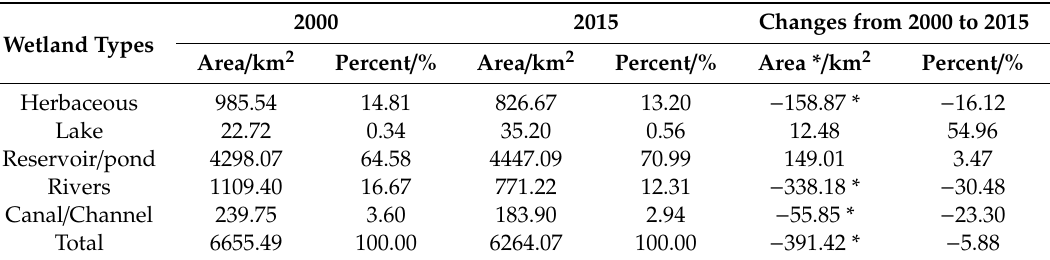
Table 1. Wetland area in the Beijing-Tianjin-Hebei Region (BTH) from 2000 to